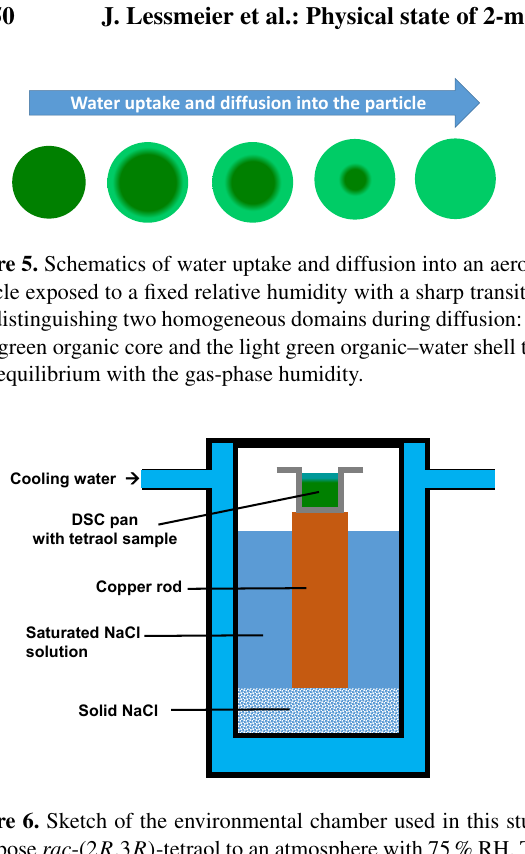
Figure 7. (a) Illustration of water uptake by a hygroscopic sub- stance and subsequent water diffusion within it for a sample inside a DSC sample pan. (b, c) DSC thermograms showing several con- secutive cooling–heating cycles of wetted rac -(2 R ,3 R) -tetraol (b) , with a close-up view of the glass transition region (c) . After each of the first four cycles the temperature was held constant at 303.15K for 20min before the next cycle was initiated. After the fifth cycle the temperature was raised to 353.15K and held constant for 20min before the last sixth cycle was